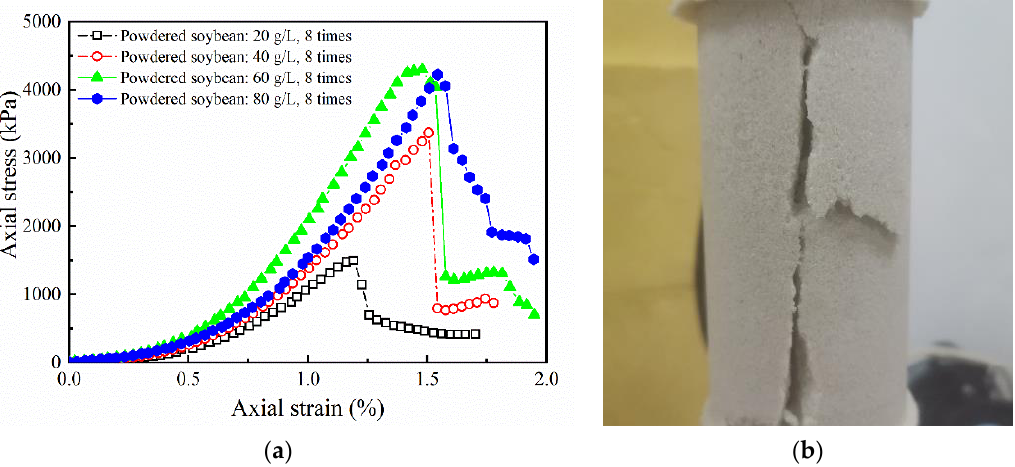
Figure 11. Results of EICP-treated sand samples: ( a ) stress – strain relationship after eight treatment cycles and ( b ) typical failure of sand sample.